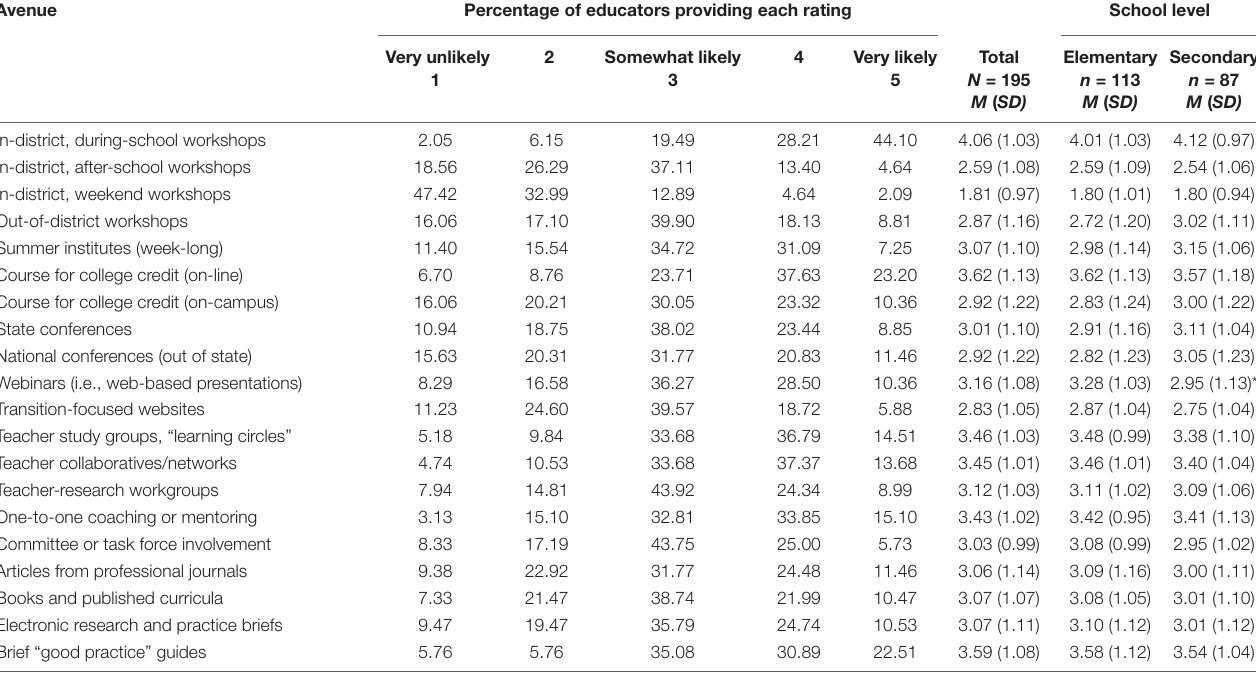
TABLE 6 | Potential avenues for professional development and learning.